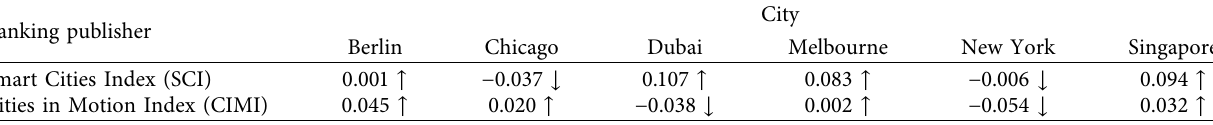
Table 7: Comparison of the change in the normalized score between 2018 and 2019 for 6 common cities as given by 2 ranking publishers.